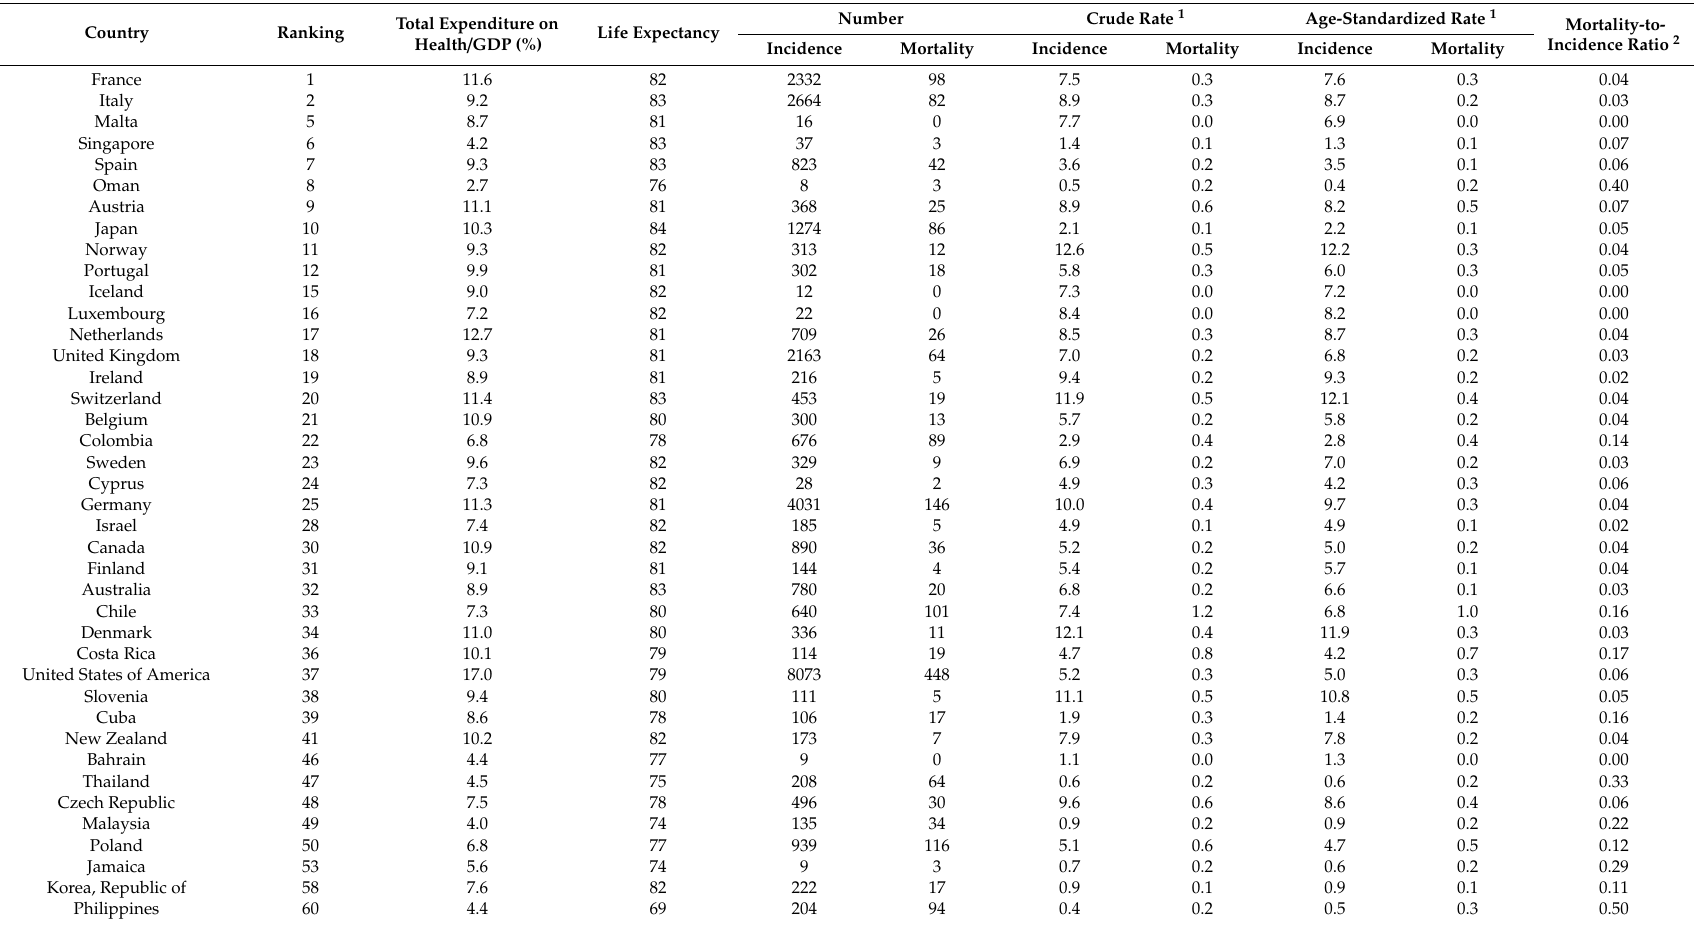
Table 2. Summary of selected countries’ World Health Organization rankings, total expenditures on health / GDP, life expectancies, testicular cancer incidences, mortality, and